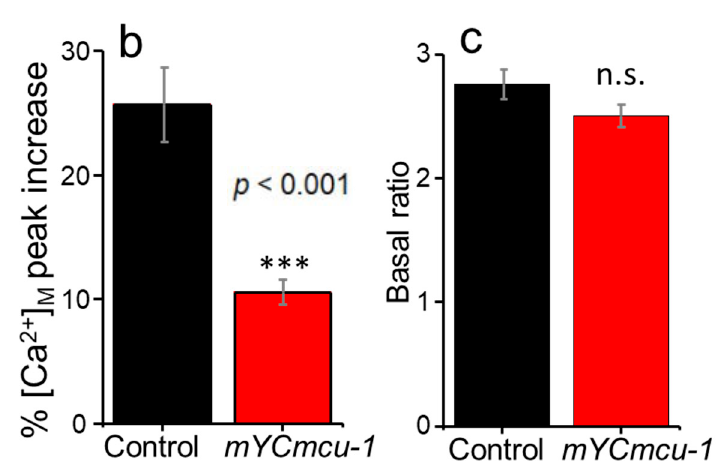
Figure 3. Effect of carbachol on pharynx [Ca 2+ ] M in both the control AQ3055 strain and the mutant mcu-1 strain. Panel ( a ) shows the mean values of fluorescence ratio obtained from 8 experiments performed in control AQ3055 worms and 10 experiments performed in mcu-1 mutants. Panel ( b ) shows the statistical data on the percentage increase in the ratio induced by carbachol, and panel ( c ) shows the basal ratio in both strains. Comparisons made with ANOVA test. ***, p <